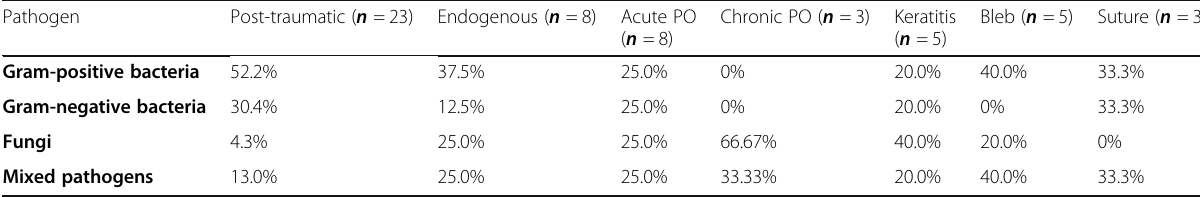
Table 2 Distribution of causative pathogens among the different groups ( n = 55). Mixed cultures yielded a combination of Gram- positive, Gram-negative, and/or fungal isolates. Gram-positive bacteria were predominant in the post-traumatic and endogenous groups, fungi in the chronic post-operative and keratitis groups, and mixed pathogens in the bleb-associated group